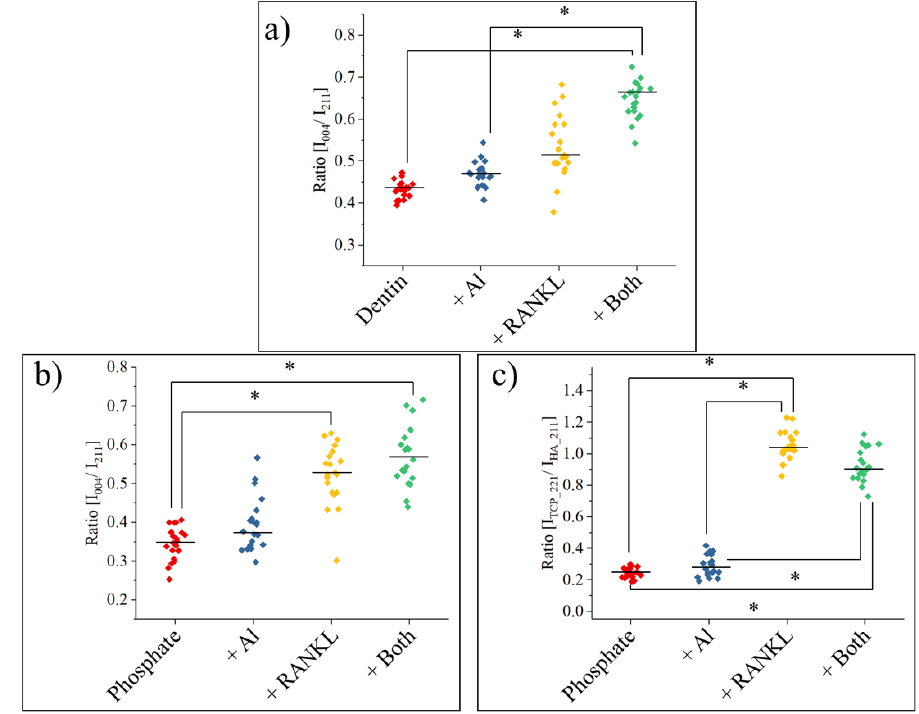
Figure 7. Spectroscopic information extracted from the X-ray diffraction patterns of Figure 7: I 004 /I 211 intensity ratio for ( a ) dentine and ( b ) octacalcium phosphate and ( c ) I TCP /I HA ratio for octacalcium phosphate. * indicate p < 0.05.